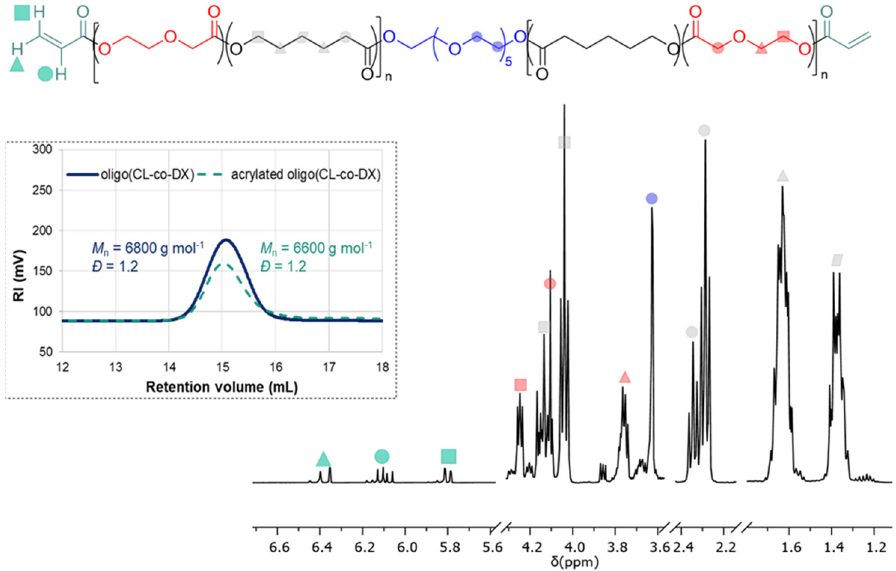
Figure 2. 1 H NMR spectra (CDCl 3 , 400 MHz) of the acrylated oligo(CL-co-DX). In the inset, SEC chromatograms of the oligo(CL-co-DX) and the acrylated